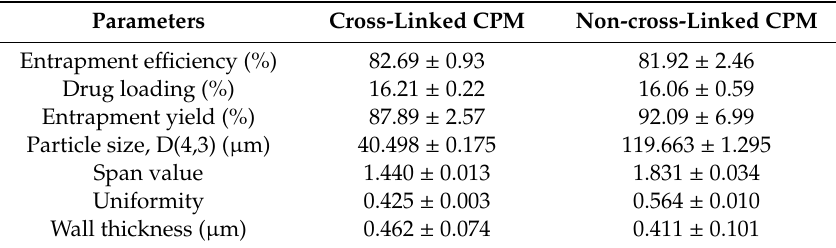
Table 1. Characterizations of curcuminoids microcapsules